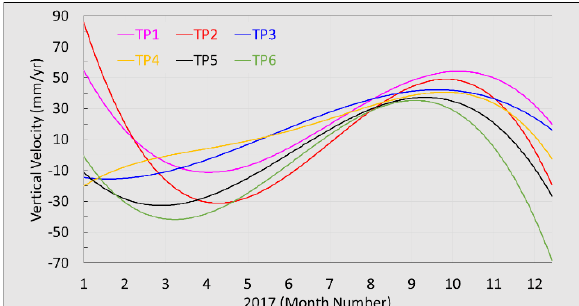
Figure 10. Comparison between SBAS and Modelled velocities for target point 6 (Figure